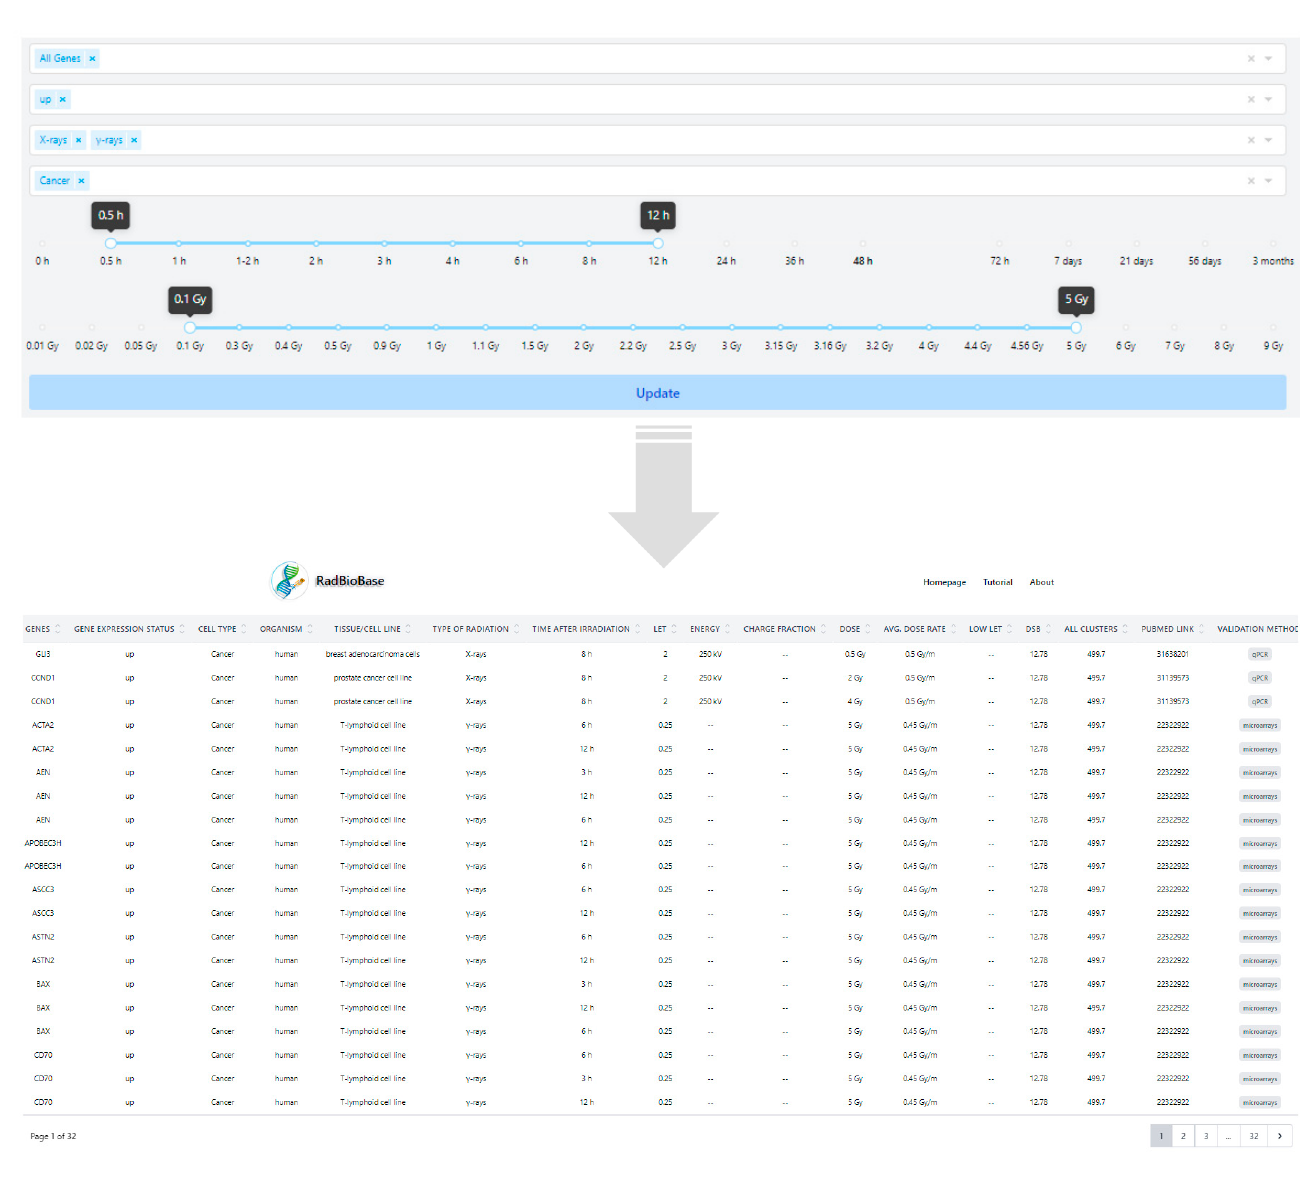
Figure 1. Example output page of RadBioBase. The database was searched using the “X-rays & γ -rays”, “Cancer” and “up” options, by selecting the time and dose ranges 0.5–12 h and 0.1–5 Gy, respectively.